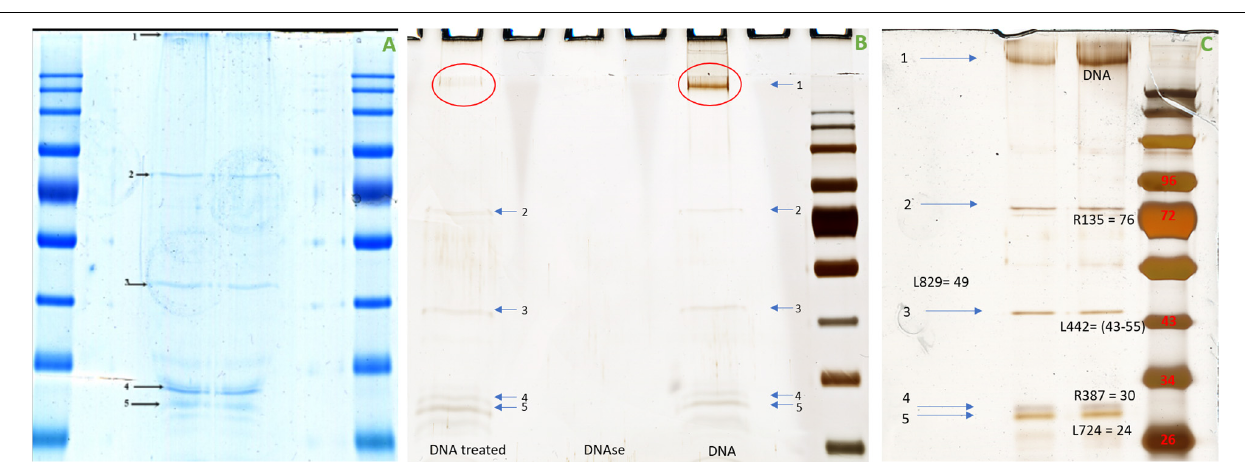
FIGURE 5 | Migration of the APMV DNA extract into polyacrylamide gel electrophoresis. (A) Coomassie blue staining (InstantBlue Protein Stain) of polyacrylamide gel electrophoresis showed five different bands possibly corresponding to proteins. (B) Silver staining of polyacrylamide gel electrophoresis showed the disappearance of band no. 1 when the APMV DNA is treated with DNase and the persistence of the band nos. 2, 3, 4, and 5. (C) Silver staining of polyacrylamide gel electrophoresis showed five bands corresponding, respectively, to DNA, R135 putative GMC-type oxidoreductase (molecular weight = 76,947 Da), cleaved sequence of the hypothetical protein L442 (molecular weight (cid:39) 48,000 Da), hypothetical protein R387 (molecular weight = 30,067 Da), and hypothetical protein L724 (molecular weight = 24,033 Da). No visible band corresponds to hypothetical protein L829 (molecular weight = 49,229 Da). The protein marker used was Color Prestained Protein Standard, Broad Range (10–250